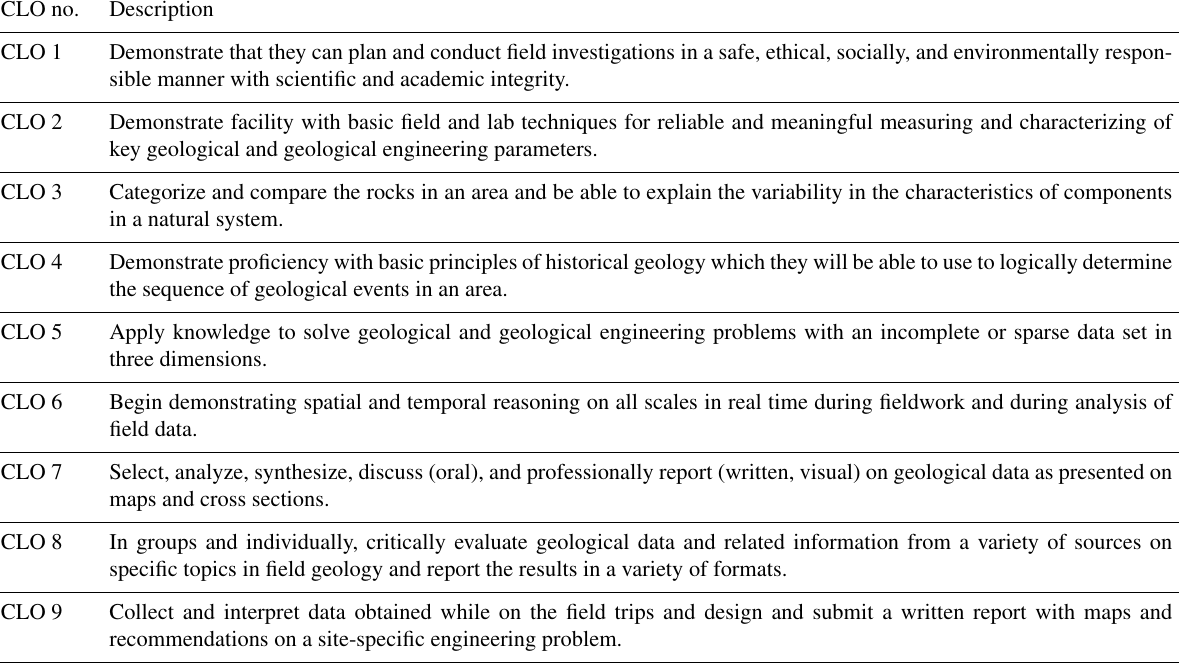
Table 1. Course learning outcomes (CLOs) for GEOE/L 221 Geological (Engineering) Field Methods in fall 2019, 2020, and 2021. CLO no.